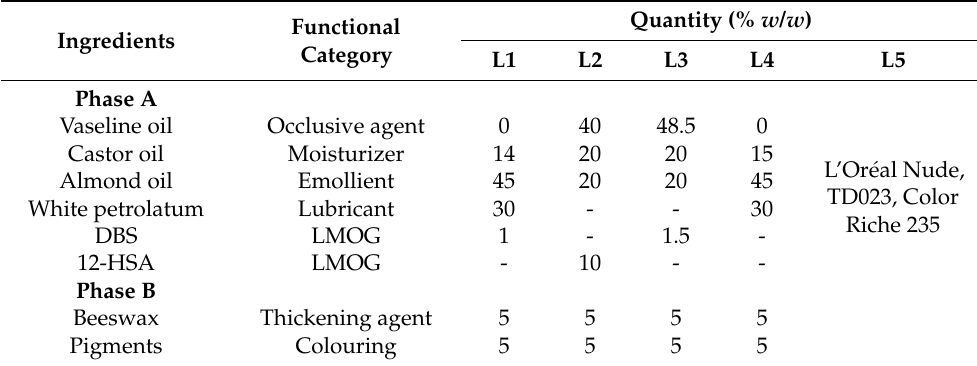
Table 3. The set of component formulations and functional categories of their